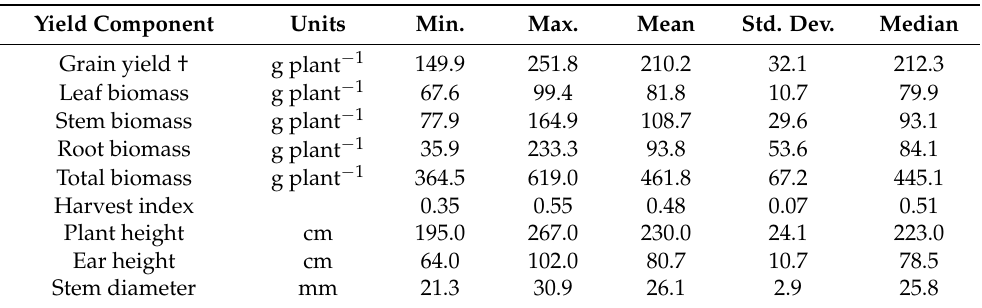
Figure 8. Grain (15.5% moisture content) and total biomass (dry basis) plant yield from harvested maize plants grown synthetically in the indoor grow room during a fertility trial. Values represent av- erages among three replications and three different hybrids grown using six different concentrations of P in fertigation (4, 8, 12, 15, 20, and 22 mg P L − 1 ). Error bars indicate standard deviation. Table 3. Summary of plant yield components from harvested maize plants grown synthetically in the indoor grow room during a fertility trial. Values are expressed on a per plant basis and represent averages among three replications and three different hybrids grown using a concentration of 8 mg P L − 1 in fertigation